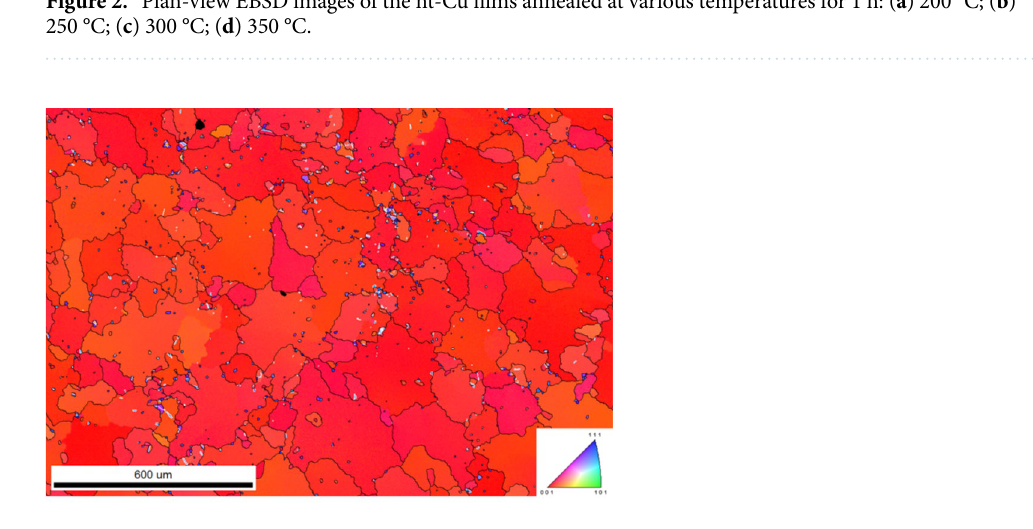
Figure 3. Plan-view EBSD image (inverse pole in z -axis) of the nt-Cu annealed at 400 °C for 1 h showing some Σ 3 grain boundaries (white